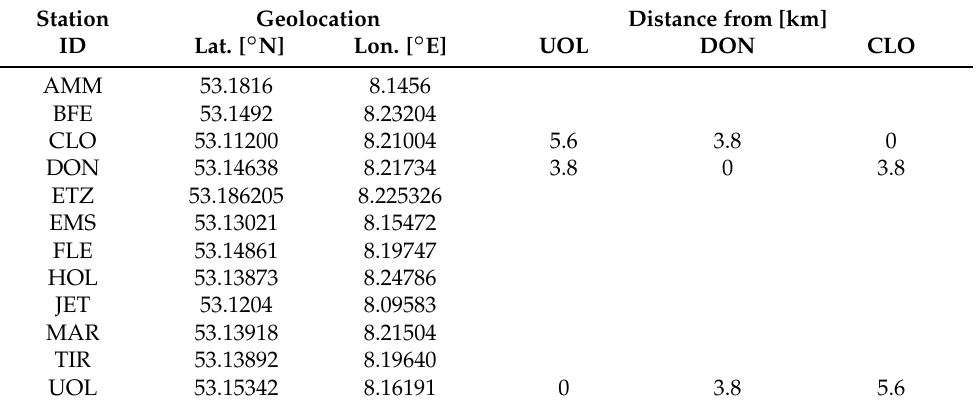
Table 1. The table gives an overview of the station IDs and geolocations of the radiometer and all-sky imager (ASI) stations of Eye2Sky which are used in this study. Additionally, the distances between the radiometer stations are given. Each radiometer station listed below is equipped with a rotating shadowband irradiometer (RSI) which uses two LI-COR LI-200 silicon pyranometers.